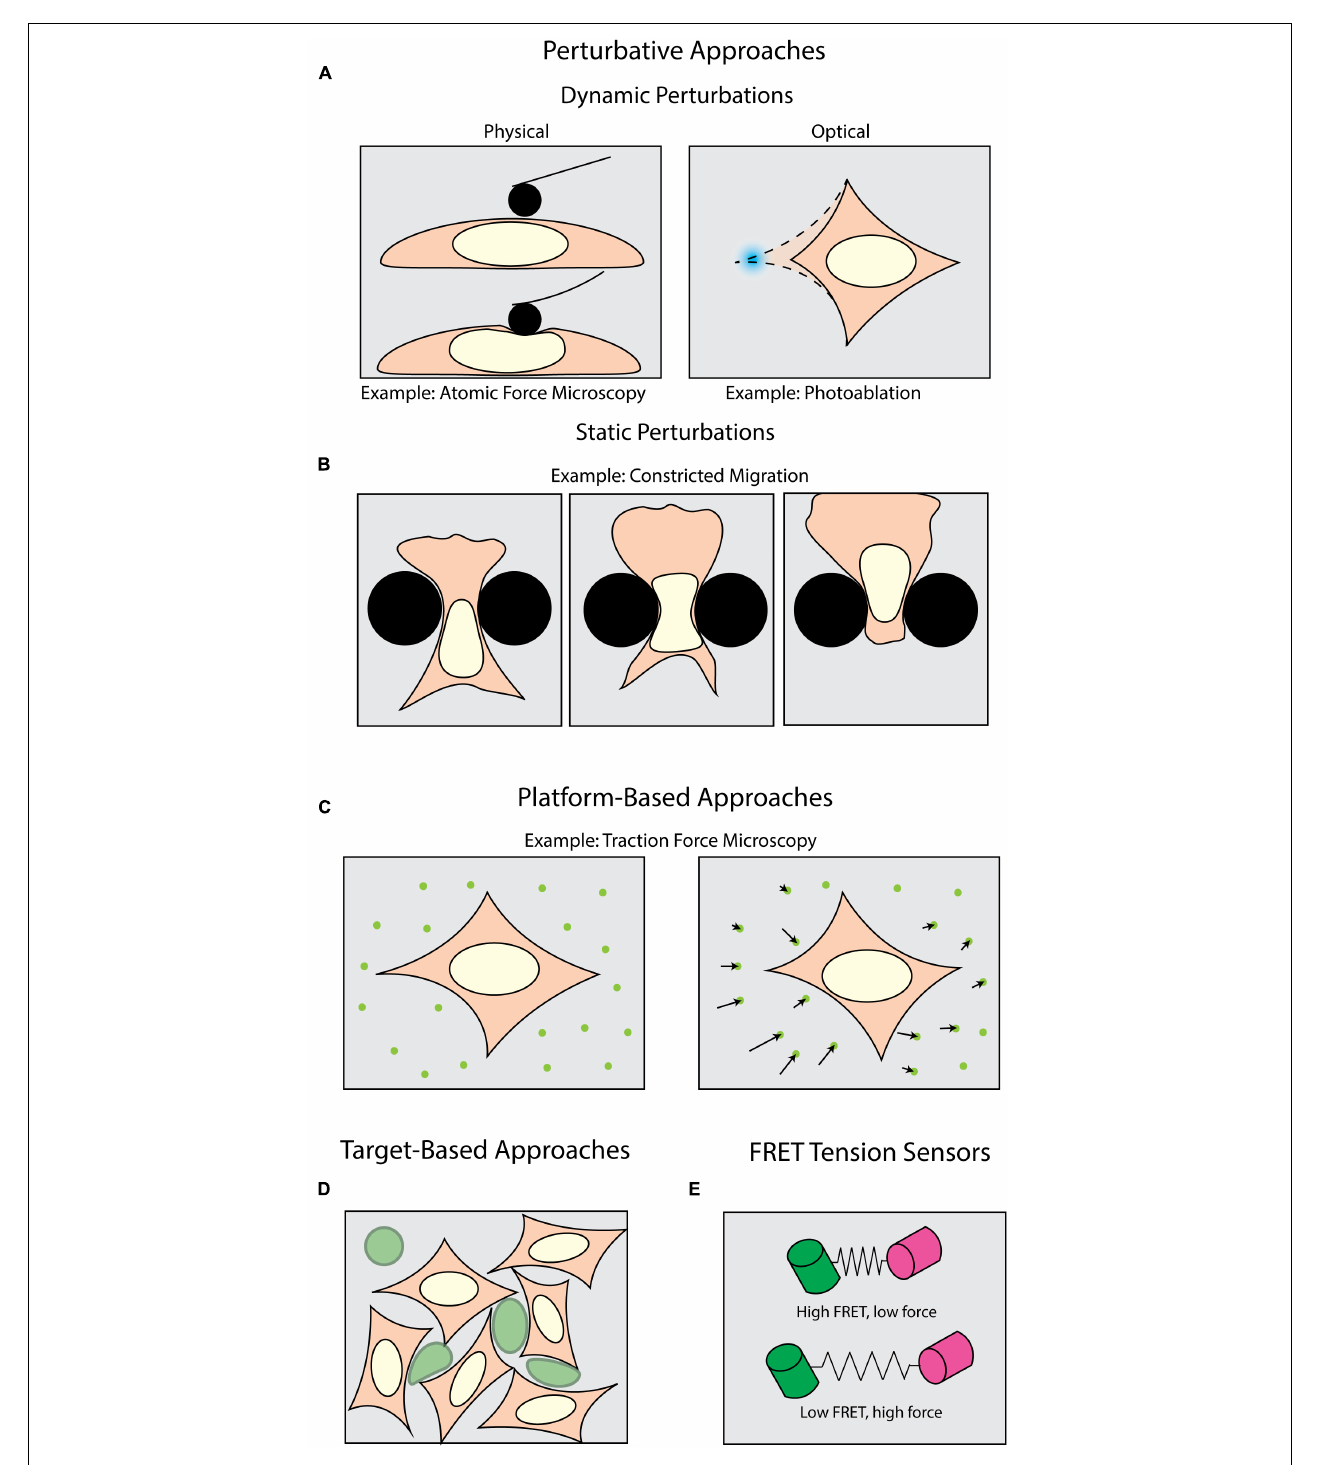
FIGURE 1 | Methods of measuring forces in biology. Perturbative techniques can be either (A) dynamic or (B) static. (A) Dynamic methods such as atomic force microscopy (AFM) use external physical probes to measure the force required to deform the sample. Dynamic optical perturbations use either photoablation to reveal underlying tension (as shown) or optogenetic tools to activate force generation. (B) Static perturbations (e.g., constricted migration assays) use rigid physical barriers to induce large-scale shape changes as cells navigate their environment. (C) Platform-based approaches, such as Traction Force Microscopy (TFM), monitor displacements of fiducial markers to measure mechanical forces cells apply to their surroundings. (D) Target-based approaches (e.g., liquid droplets) measure the deformation of micron-scale particles (green) to infer forces generated within tissues or during target engagement. (E) FRET tension sensors use molecular springs between donor and acceptor fluorophores to convert FRET signals to intracellular